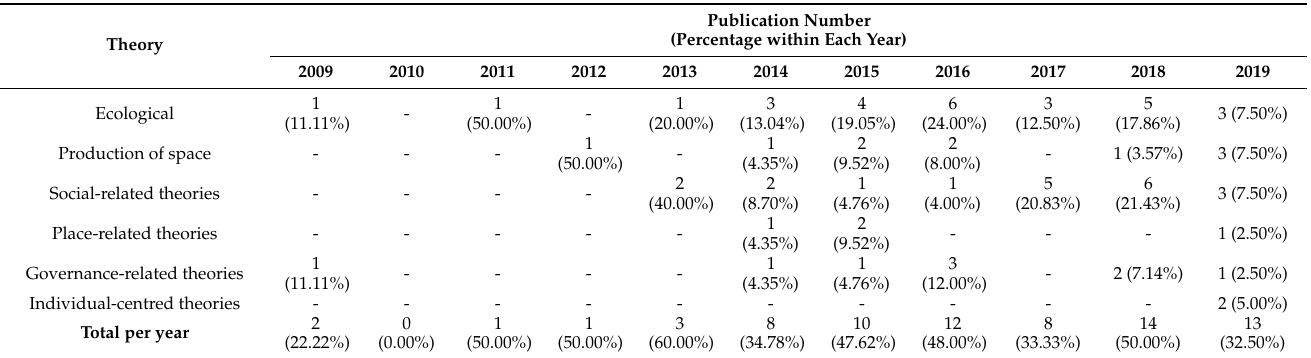
Table 1. Publication trend of different theory groups in